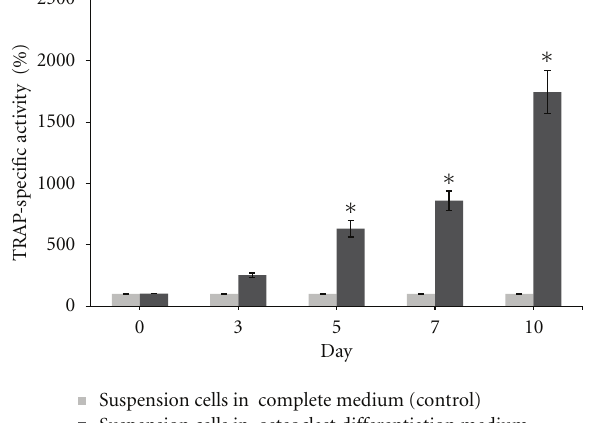
Figure 5: Percentage of TRAP-specific activity of suspension mononucleated cells during osteoclast di ff erentiation. There was a significant increase in TRAP activity in adherent cells cultured in osteoblast di ff erentiation medium at day 5, 7, and 10 of di ff erentiation, using a paired t -test ∗ indicates a significant ( P < 0 . 05) increase in TRAP enzyme activity compared to control cells. Results are presented as the mean ± SD ( n = 3). TRAP-specific activity in control cells was used for the basal rate